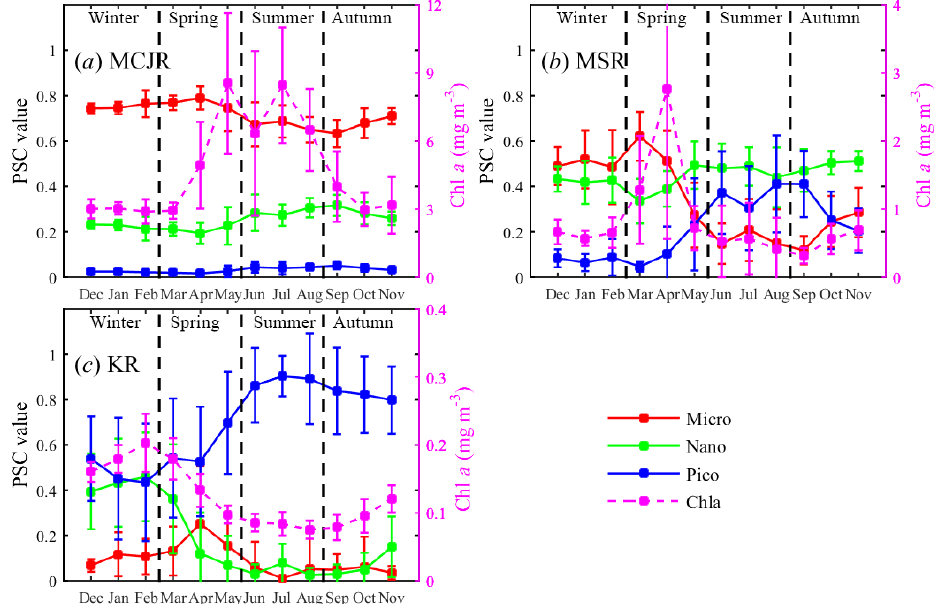
Figure 9. Monthly climatological PSC and Chl a from 2003 to 2016 in the mouth area of the Changjiang River (MCJR) (a) , middle shelf region (MSR) (b) , and Kuroshio region (KR) (c) . Error bars indicate standard deviations of the